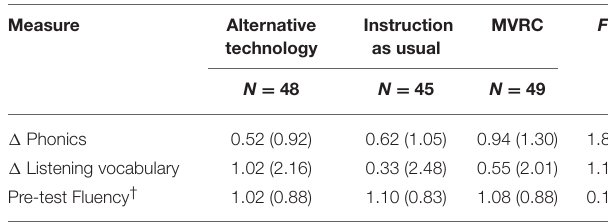
TABLE 5 | Averages obtained for 2th-graders from District 2, separated by